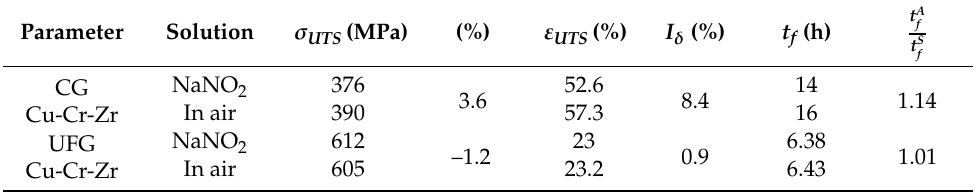
Figure 3. The average ultimate tensile strength (UTS) and elongation of CG and UFG alloys with NaNO 2 solution and air. Table 3. Stress corrosion cracking (SCC) results of Cu-Cr-Zr alloys in 1 M NaNO 2 solution.